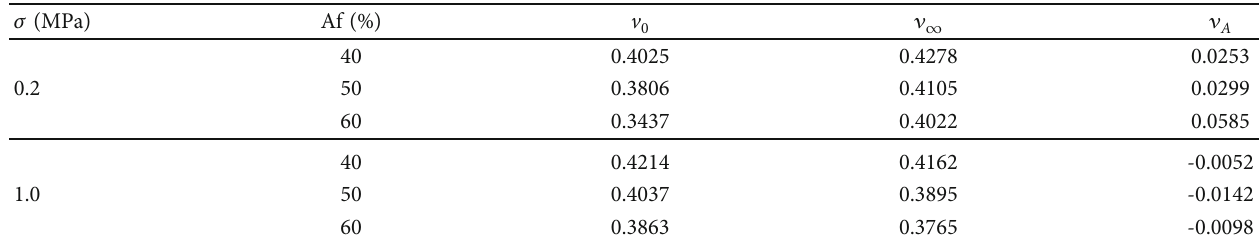
Table 6: Characteristic parameters of Poisson ’ s ratio under di ff erent area